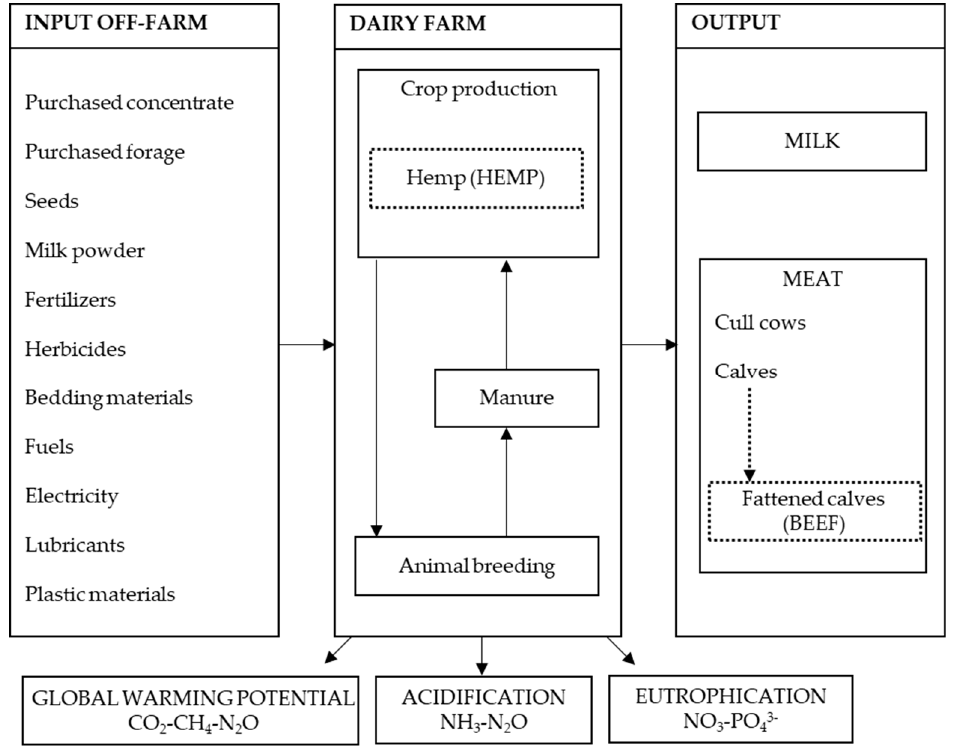
Figure 1. System boundaries diagram of Life Cycle Assessment applied to dairy farms. The dotted lines represent the alternative scenarios considered in the study.